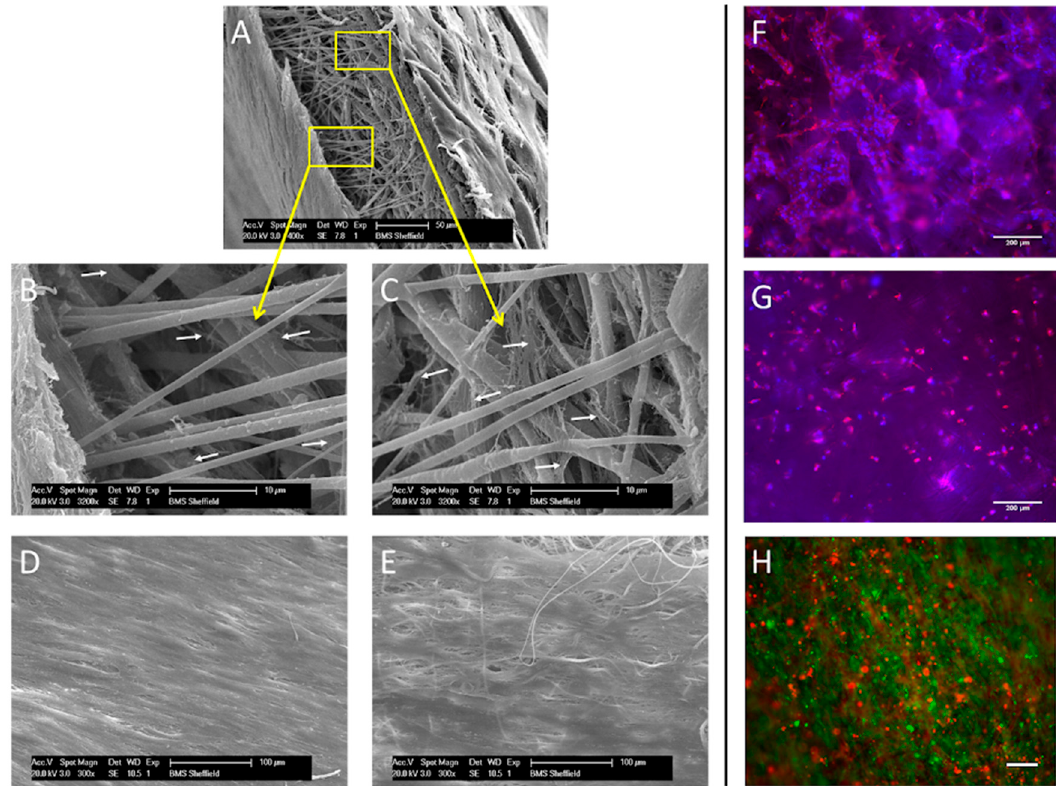
Figure 5. SEM side ( A – C ) and face views ( D , E ) showing the top ( B , D ) and bottom ( C , E ) of a monolayer microfiber PCL scaffold seeded on the top face only with hES-MPs after 28 days culture. Cells (white arrows) can be seen throughout the scaffold ( B , C ) and as sheets covering both outer surfaces ( D , E ), ( A —scale bar = 50 µm; B , C —scale bar = 10 µm; D , E —scale bar = 100 µm) hES-MPs seeded on the top surface can also be detected by immunolabeling on the top ( F ) and bottom ( G ) surfaces of a microfiber PCL scaffold (scale bar = 200 µm). The images show cell nuclei (blue) and actin filaments (red) on both surfaces. Co-seeding of fibroblasts (green) and hES-MPs (red) on opposing sides of a similar scaffold results in intermingling of cells at the end of the culture period (( H ), scale bar = 50 µm).